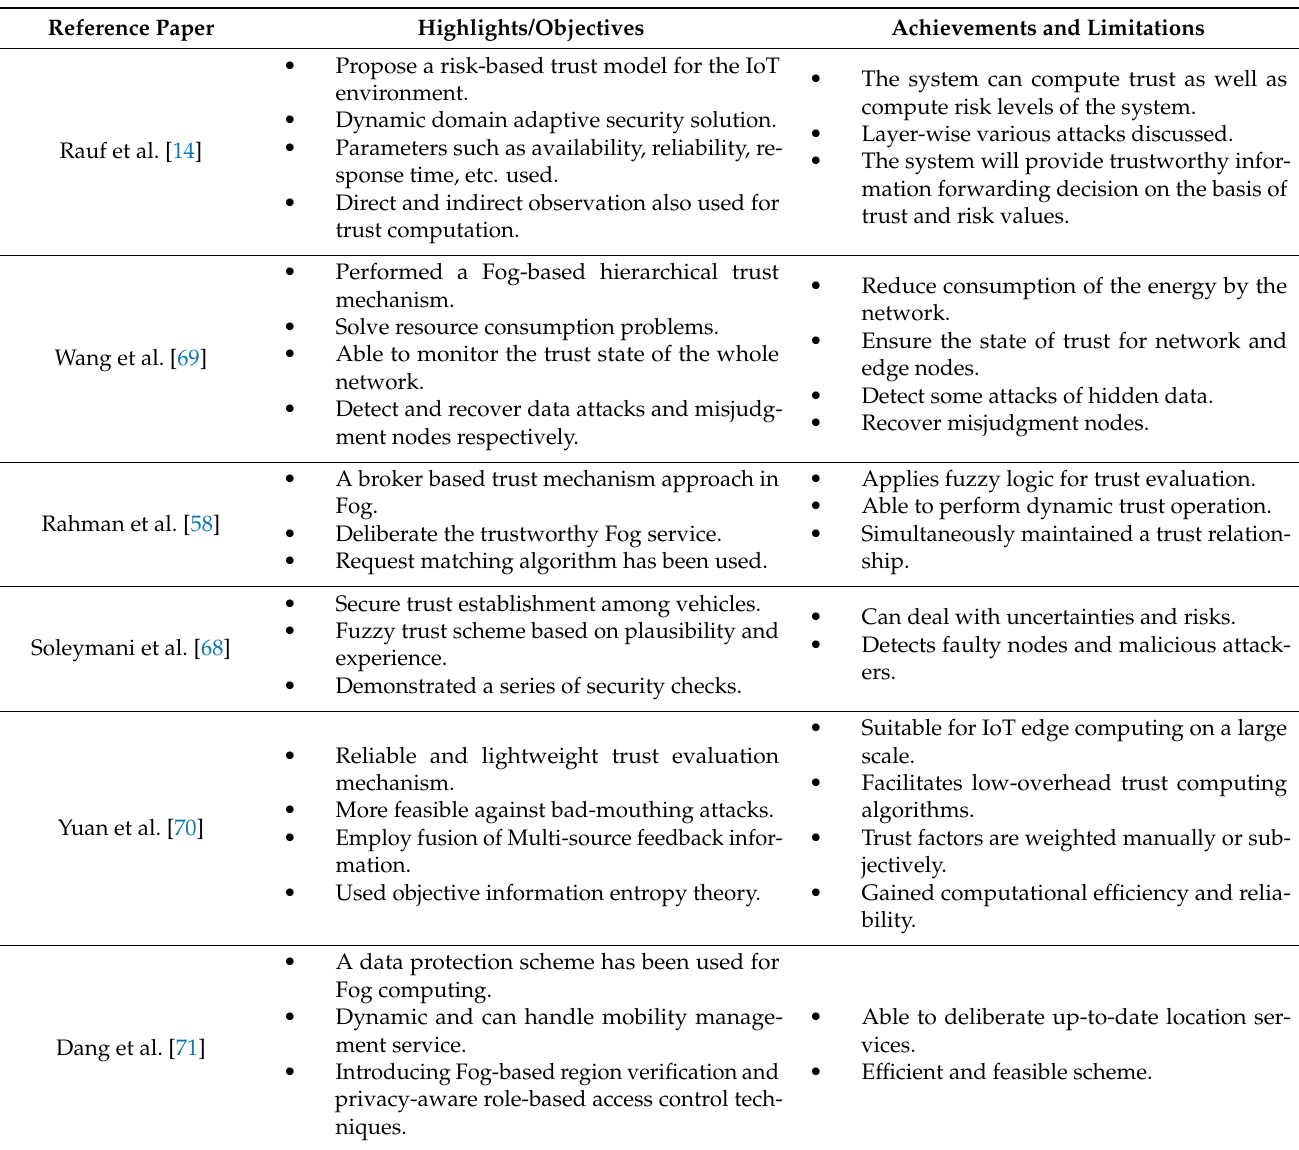
Table 6. The summary of Trust Issues in Fog environments from major survey